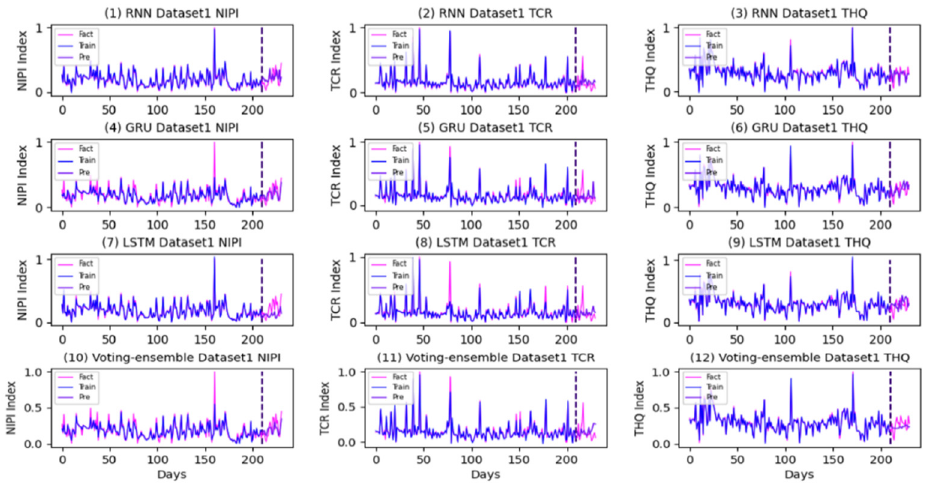
Figure 16. Prediction and actual curves generated using the RNN, GRU, LSTM, and the proposed method in Dataset1.